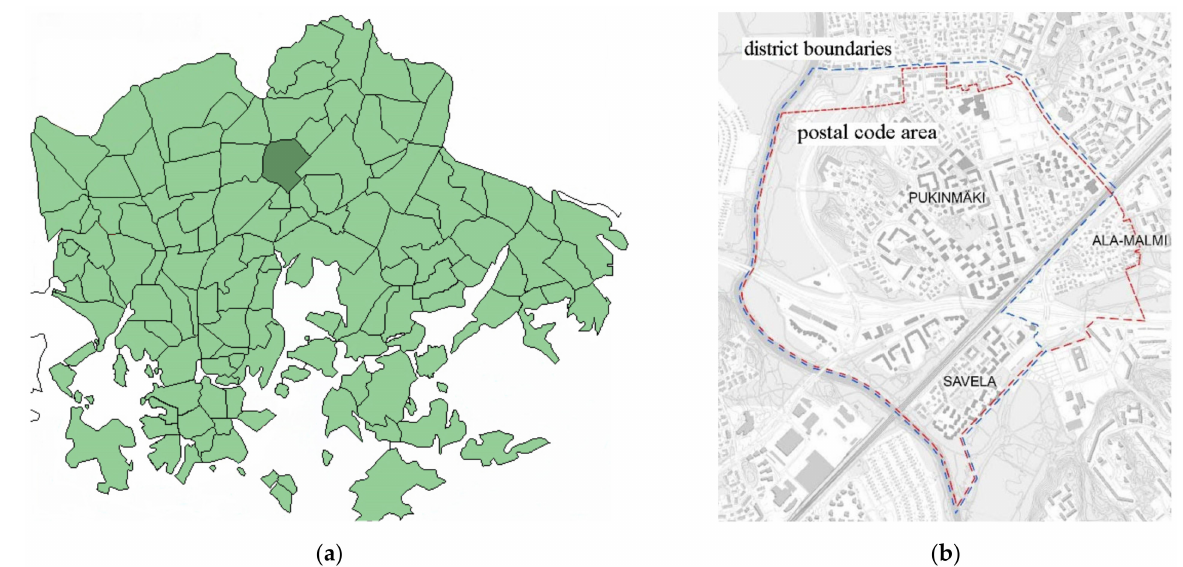
Figure 1. Pukinmäki–Savela area in the City of Helsinki (Finland); ( a ) position of Pukinmäki–Savela area within Helsinki subdivision map; ( b ) district boundaries and postal code area of Pukinmäki–Savela